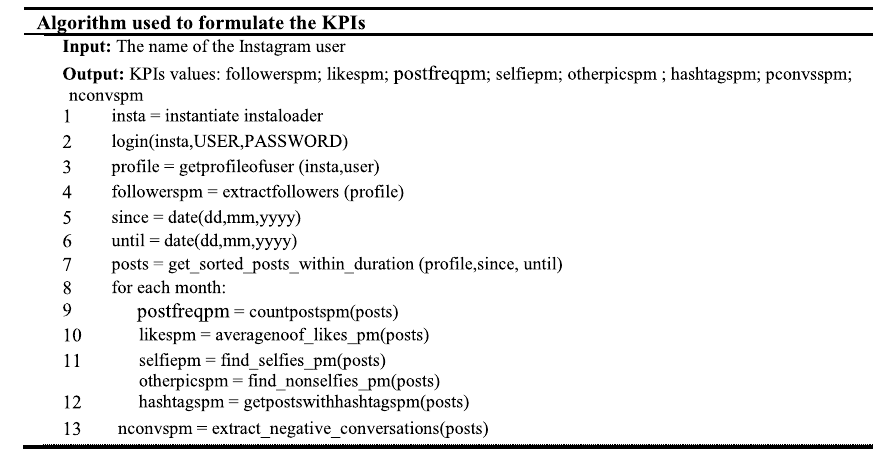
Fig. 10 Algorithm showing steps to extract data for